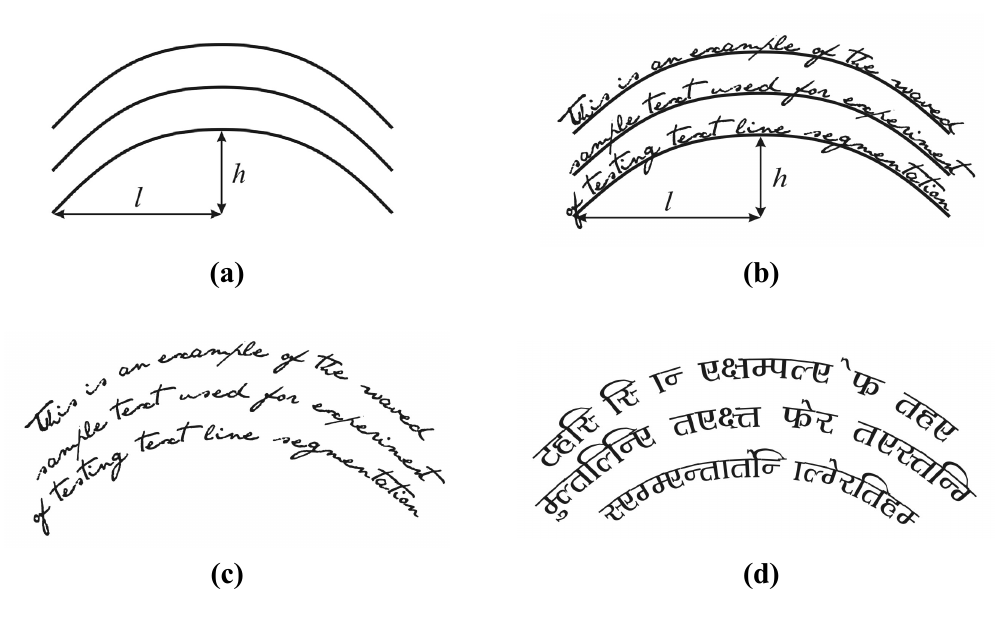
Figure 3. Multi-line waved text: (a) Reference line definition. (b) Text over reference line. (c) English text. (d) Bengali text.